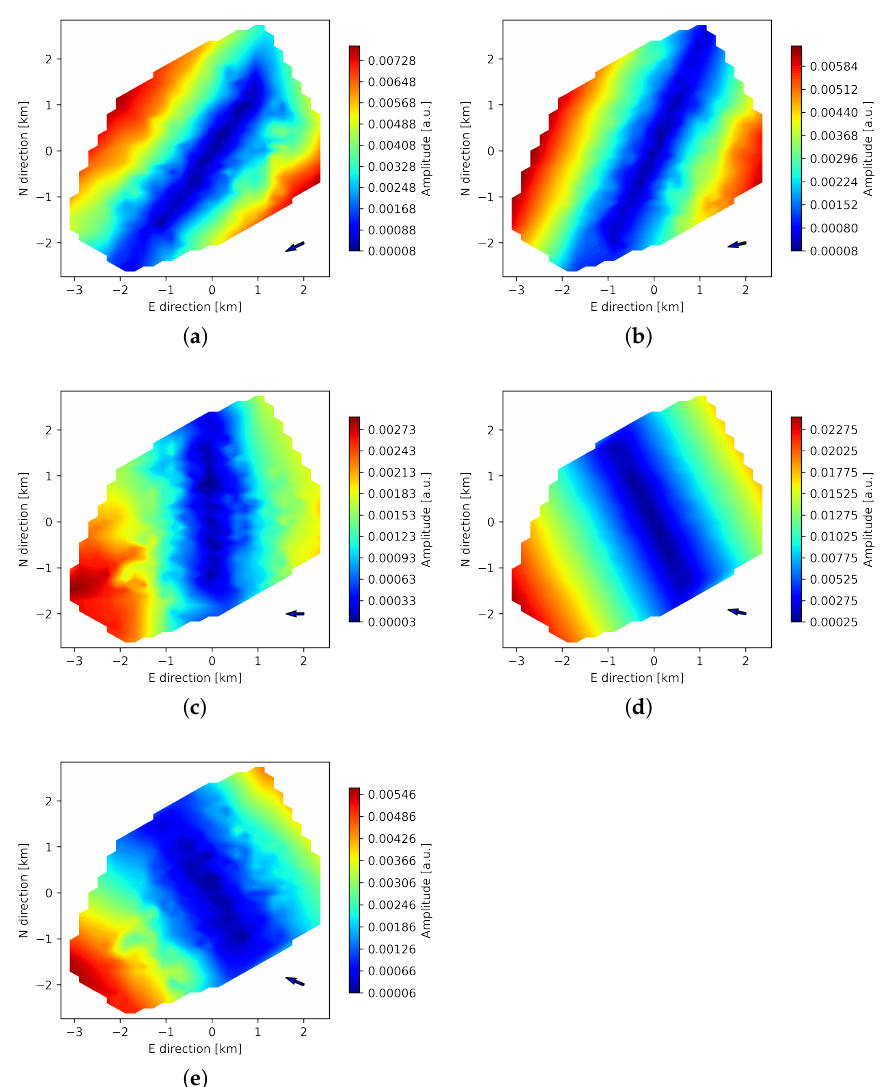
Figure 10. Amplitudes of core stations for observation L79324 for peaks 1–5 of L82655 peaks set (panels ( a – e )) at 4 min central period (see